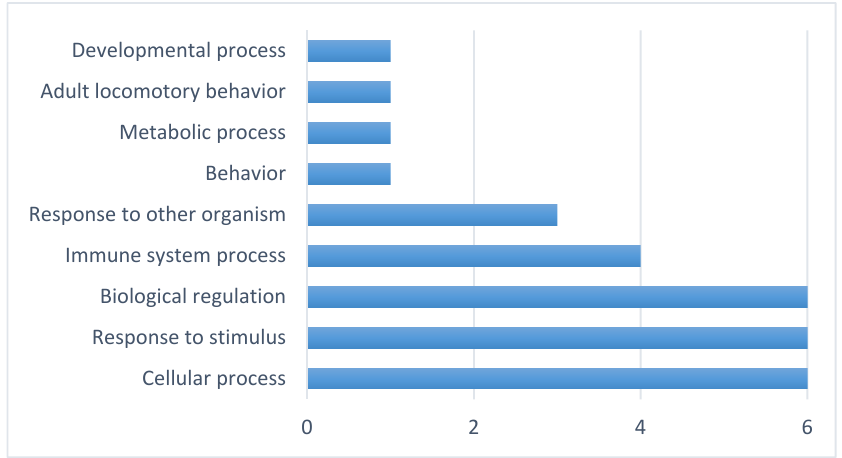
Figure 8. Total number of biological processes of candidate genes identified with GWAS for logFEC using 170 SNPs and the 507 and 50K SNP chips.